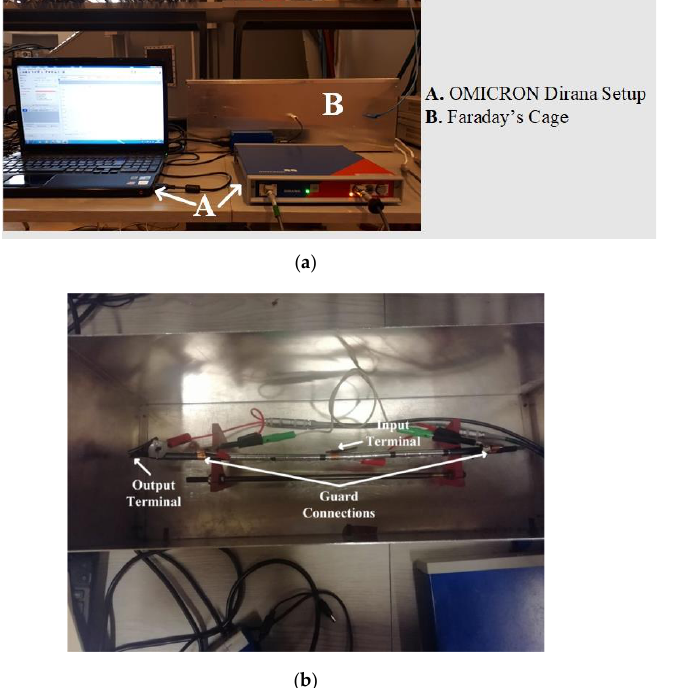
Figure 4. (a) OMICRON Dirana Setup, (b) Cable connection for measurement 166 Figure 4. The test setup: ( a ) Omicron Dirana equipment; ( b ) cable sample in the Fraday’s